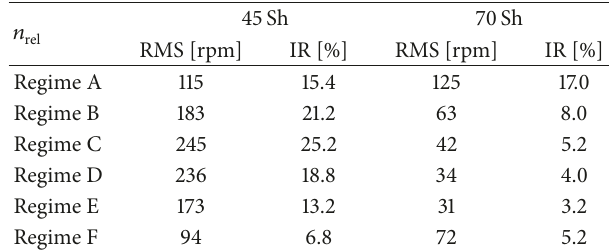
Table 2: Statistical parameters of 𝑛 rel computed for the stationary